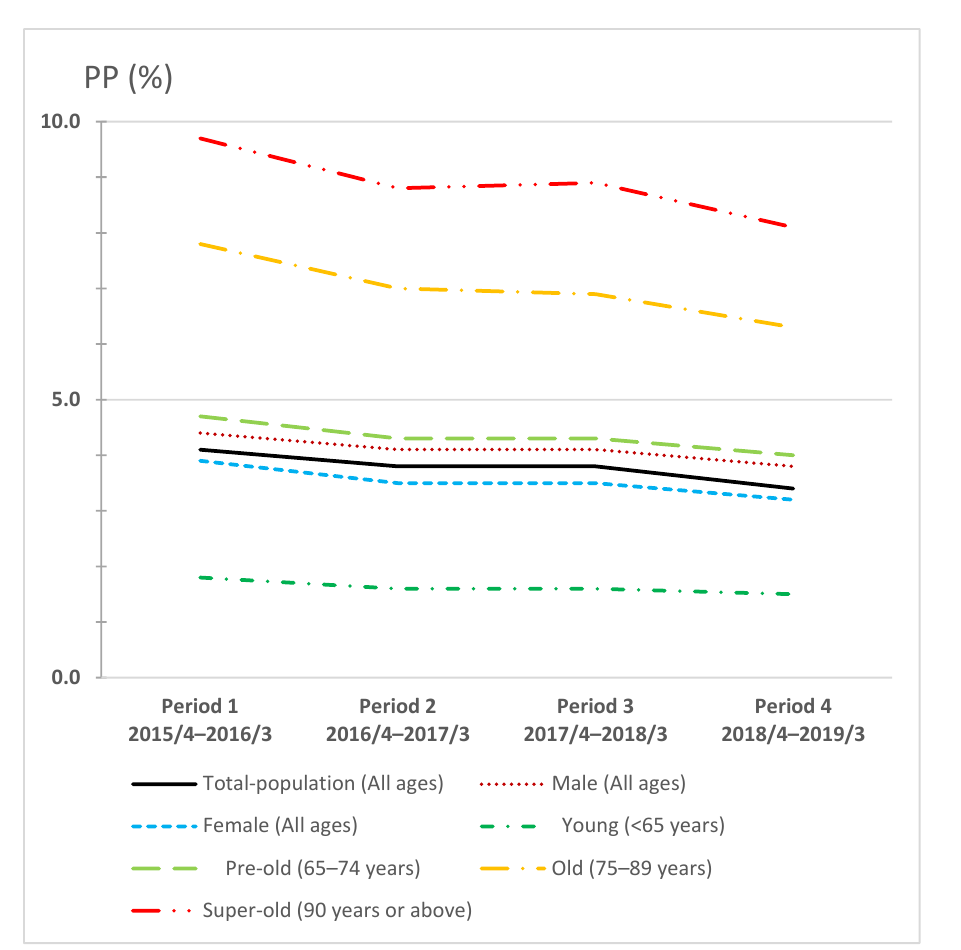
Figure 3. Age- and sex-based polypharmacy proportion trends across four years in Japan. Figure 4 describes the PP in different prefectures in Period 1 (April 2015–March 2016) and the PP in different prefectures in Period 4 (April 2018–March 2019) to show the PP changes by prefecture over four years. We used red for ≥ 5.0%, yellow for 4.0–4.9%, and green for <4.0%. The red ( ≥ 5.0%) decreased from 9 to 0, and the green (<4.0%) increased from 15 to 38 after the policy implementation. Moreover, no prefectures worsened from yellow to red or from green to yellow during the